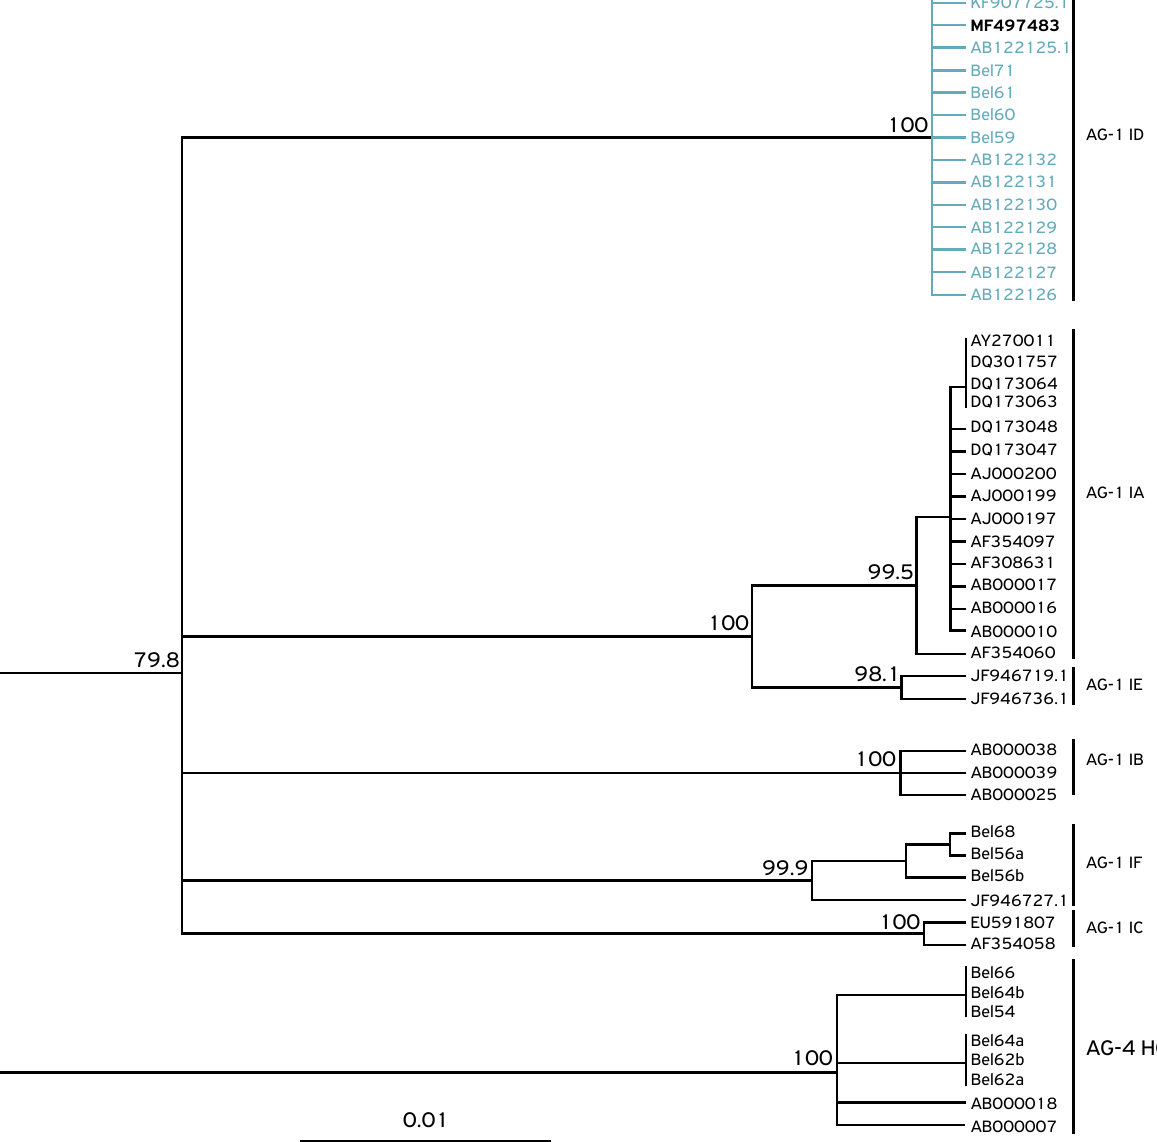
Figure 3. Phylogenetic analysis (UPGMA distance) of the rDNA’s ITS-5.8S region from Rhizoctonia solani isolates of the AG-1 anastomosis group (AG-1 IA, IB, IC, ID, IE and IF) to identify the isolate associated with web blight on okra (MF497483 sequence, in bold) at Manaus, Brazil. Sequences obtained from R. solani AG-4 HGI isolates were used as outgroup. Consensus tree was obtained by bootstrap for 1,000 replicates. The values in branches indicate the bootstrap support